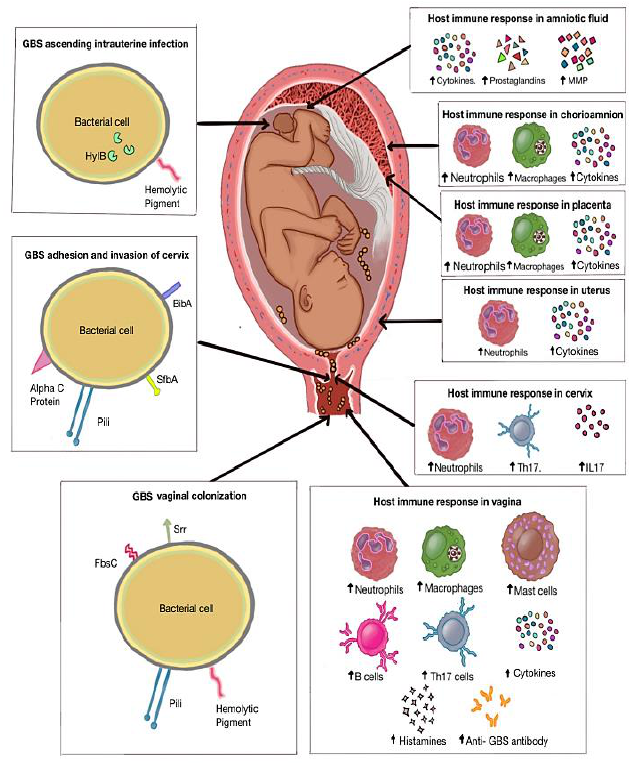
Figure 1: GBS virulence factors that are necessary for vaginal colonization, by adhering to vaginal epithelial cells include Srr, FbsC, PilA. Srr, BibA, Alpha C protein, PilB and SfbA are found to mediate GBS adhesion and invasion of cervical epithelial cells. Hemolytic pigment and HylB are demonstrated to be important for ascending intrauterine infection. Host innate immune components